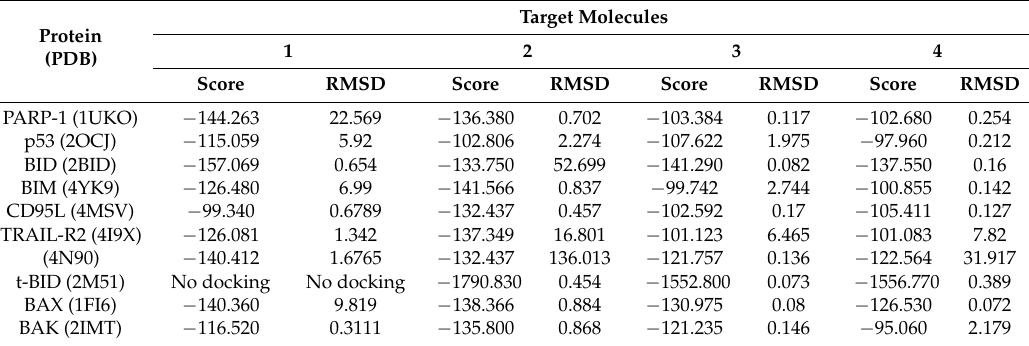
Table 3. Energy values of the interaction (score) between the ligands with the protein and their root mean standard deviation (RMSD in Å ).